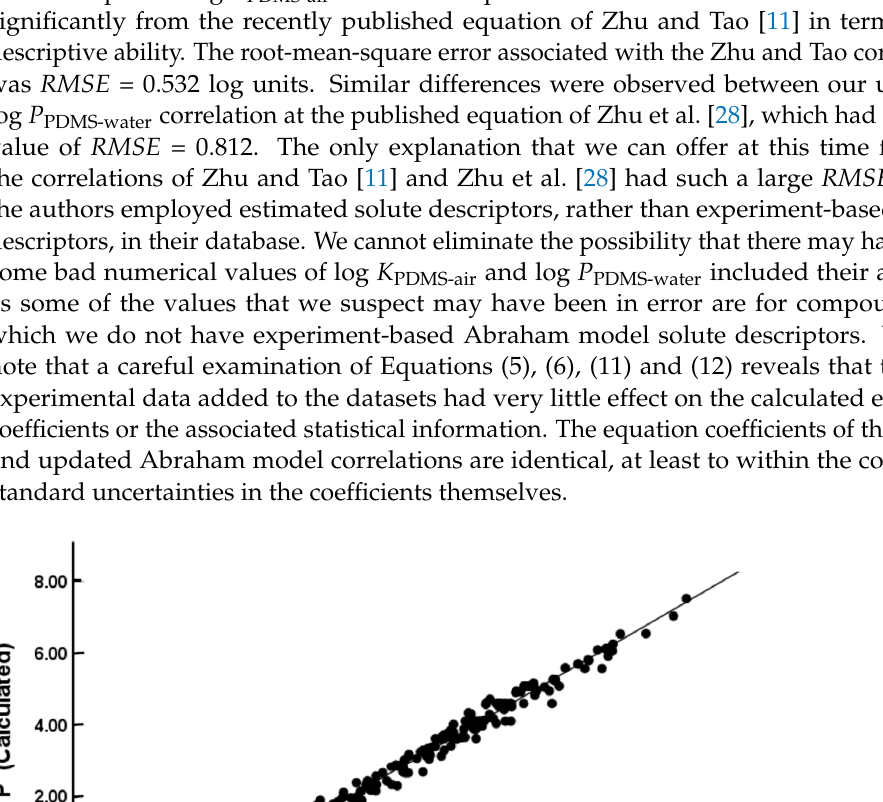
Figure 2. Comparison of observed log K PDMS-air data versus back-calculated values based on Equation (12) for PDMS.